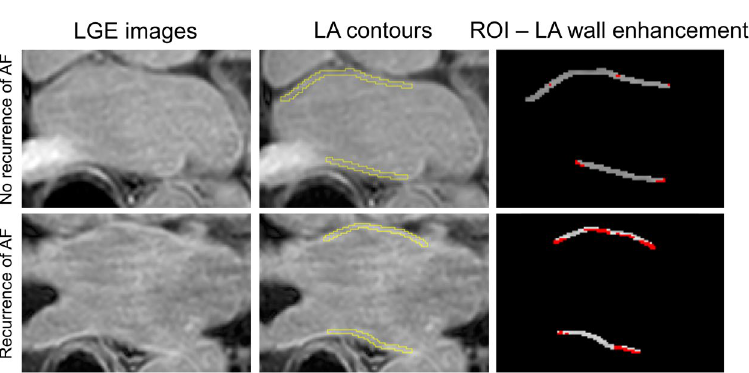
Figure 2. Late gadolinium enhancement (LGE) images of a patient with recurrence and without recurrence of atrial fibrillation (AF). Contours were manually drawn at the epicardial and endocardial borders of the left atrial (LA) wall. For analysis, all LA wall region of interests (ROIs) were cropped and an individual threshold intensity was applied per slice, which was likely to correspond to the enhanced/fibrotic voxels (red colored voxels) of the LA wall. Fibrotic voxels were determined as followed: In a first step, the lower region of the pixel intensity histogram of the LA ROIs (between 2% and 40% of the maximum intensity) were defined as “normal”. In a second step, the fibrotic threshold was then calculated as two to four standard deviations above the mean of “normal” and checked for appropriateness with the original LGE images. The most used cutoff was three standard deviations. The patient with no recurrence of AF had a left atrial wall enhancement of 10.2%. The patient with recurrence had an enhancement of